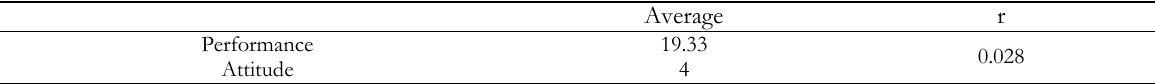
Table 6. Result of correlation